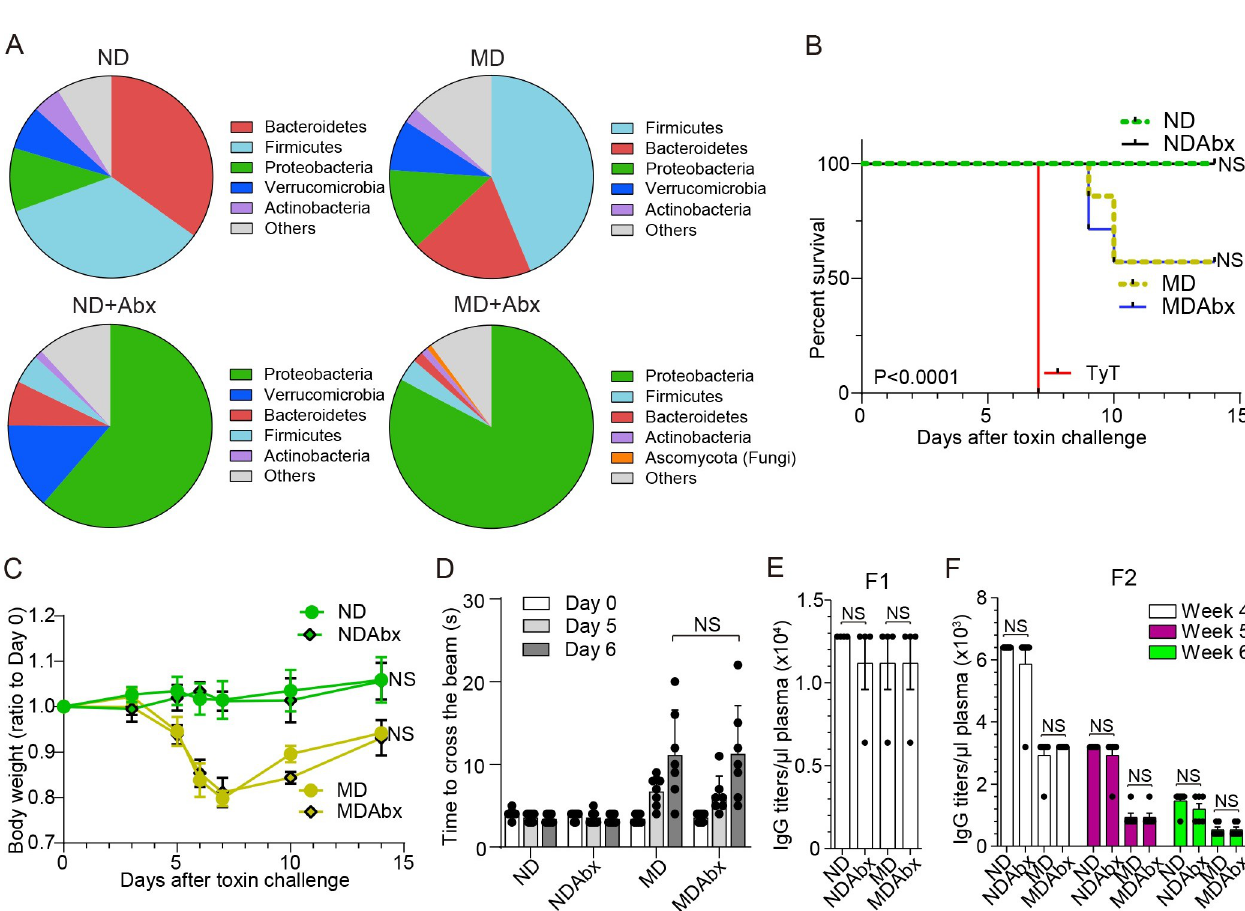
Fig 5. MD-induced gut microbiome alterations had no effects on maternal vaccination outcomes against typhoid toxin. A , The small intestine microbiome compositions of ND (n = 3), MD (n = 3), ND+Abx (n = 2), and MD+Abx (n = 2). See also Table 3. B, Survival of the maternally vaccinated (PltBVac) F2 mice challenged with 2 μ g typhoid toxin (TyT). ND (green dotted), normal diet-fed F2 mice. NDAbx (black solid), normal diet-fed F2 mice obtained from corresponding antibiotics treated F1. MD (olive dotted), malnourished diet-fed F2 mice. MDAbx (blue solid), malnourished diet-fed F2 mice obtained from corresponding antibiotics treated F1. TyT (red solid), standard regular food-fed F2 mice derived from unvaccinated mothers. C. Relative body weight changes of these F2 mice after receiving 2 μ g typhoid toxin for the 14 day-experimental period. D. Balance beam walking results of these F2 mice on days 0, 5, and 6 after the toxin challenge. E. IgG titers specific to PltB pentamer available in 1 μ l plasma samples of the indicated F1 mothers (19 days of pregnancy). F. Maternal antibody titers specific to PltB pentamer available in 1 μ l plasma samples of indicated F2 mice from weeks 4 to 6. The typhoid toxin challenge was conducted in week 5. Lines and bars represent the mean ± SEM. n = 4 (F1) and 6-7 (F2) mice per group. NS, not significant. The log-rank test was performed for B and two-tailed unpaired t-tests for C-F.